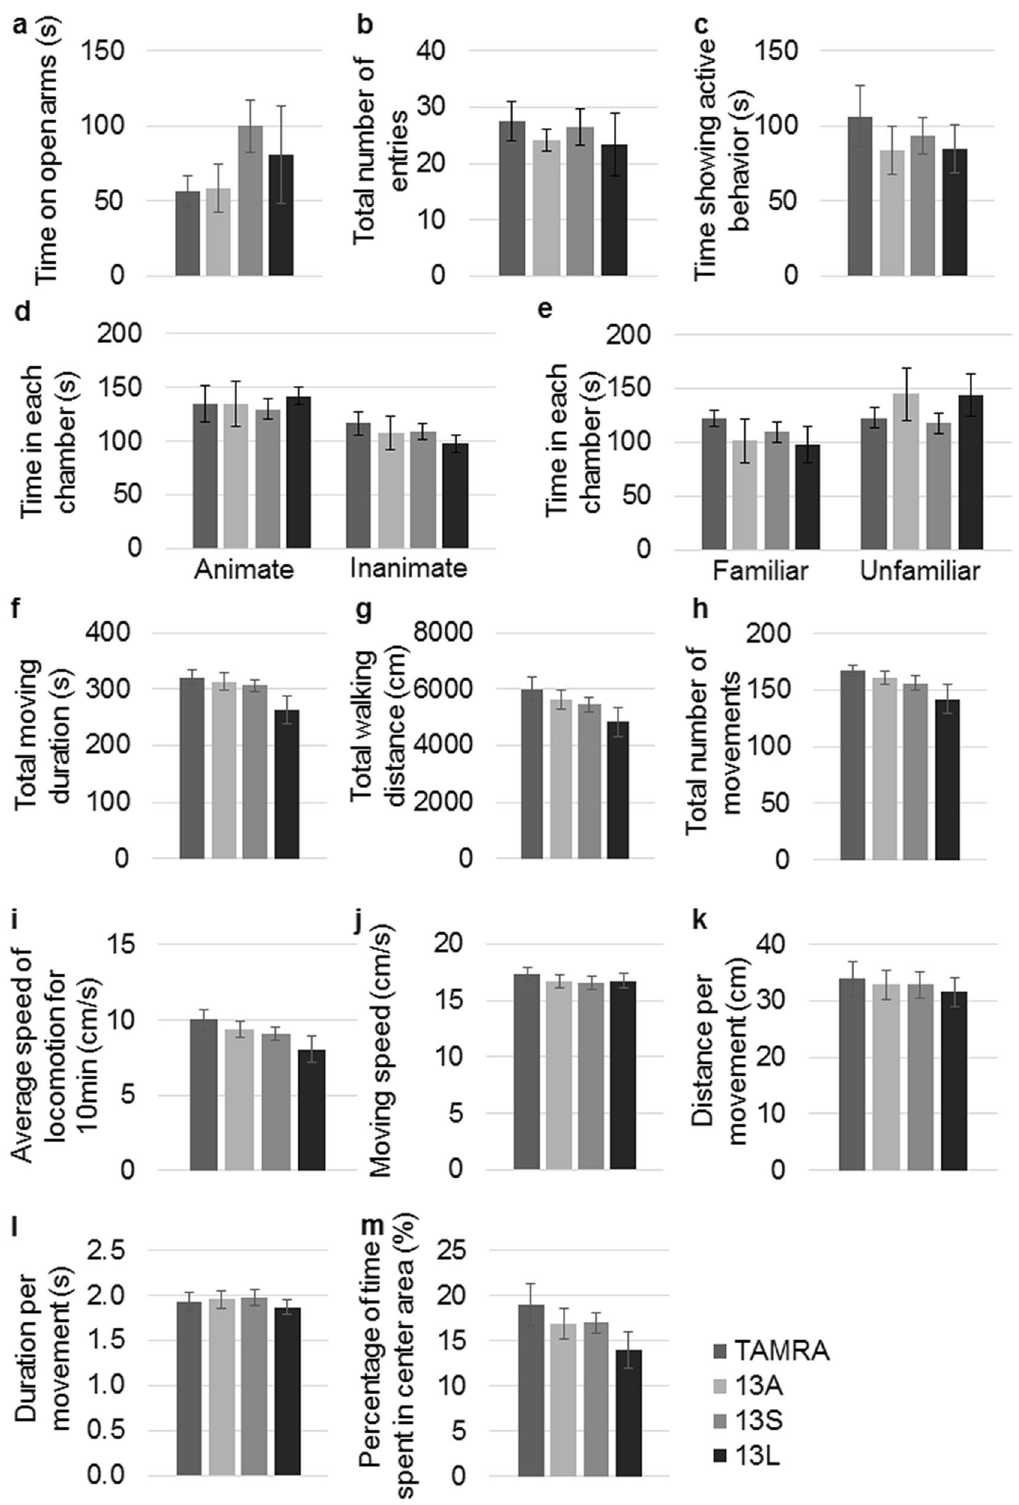
Figure 5. Injection of CM derived from BV2 microglia treated with 13A, 13S or 13L into lateral ventricle does not alter anxiety, active behavior, social behavior and spontaneous motor activity. ( a , b ) Elevated plus maze test. Time on open arms ( a ) and total number of entries into the arms ( b ) were measured in mice injected with CM from TAMRA-, 13A-, 13S- or 13L-treated BV2 cells. ( c ) Resident- intruder test. Total time showing active behavior (approaching, chasing, sniffing) against intruder mouse was measured in mice. ( d , e ) Three chamber social test. The times spent in the chamber with (animate) and without (inanimate) a mouse ( d ) and the times spent in the chamber with the same mouse (familiar) and a novel mouse (unfamiliar) ( e ) were measured. ( f – m ) Open field test. Total moving duration ( f ), total walking distance ( g ), total number of movements ( h ), average speed of locomotion for 10 min ( i ), moving speed ( j ), distance per movement ( k ), duration per movement ( l ) and percentage of time spent in the center area ( m ) were measured. n = 10 each, 5 males and 5 females. Error bars represent